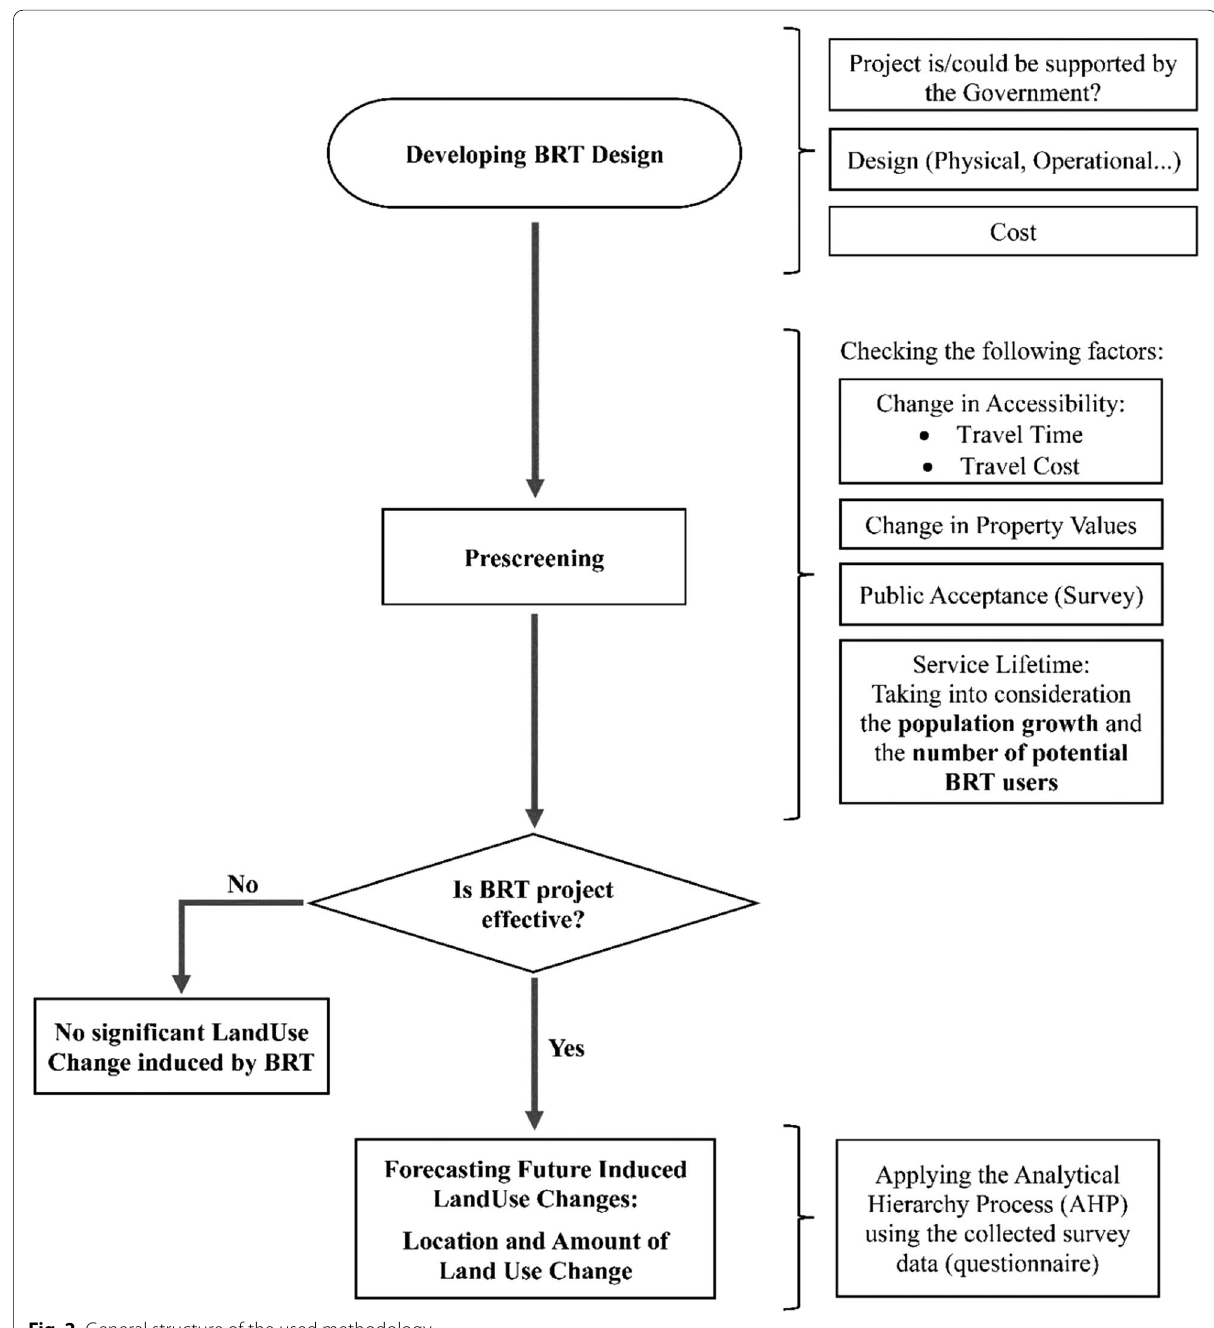
Fig. 2 General structure of the used